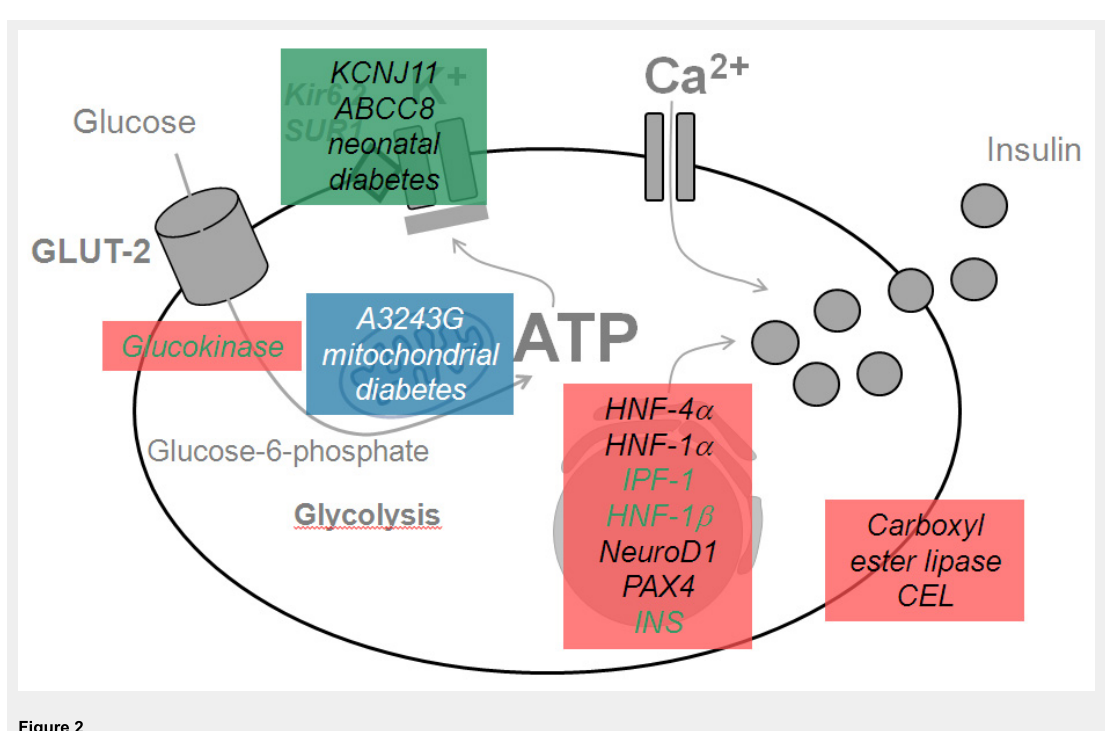
Figure 2 Location of the gene mutations and affected proteins in the pancreatic beta cell in monogenic diabetes mellitus. MODY (red), mitochondrial diabetes (blue) and neonatal diabetes